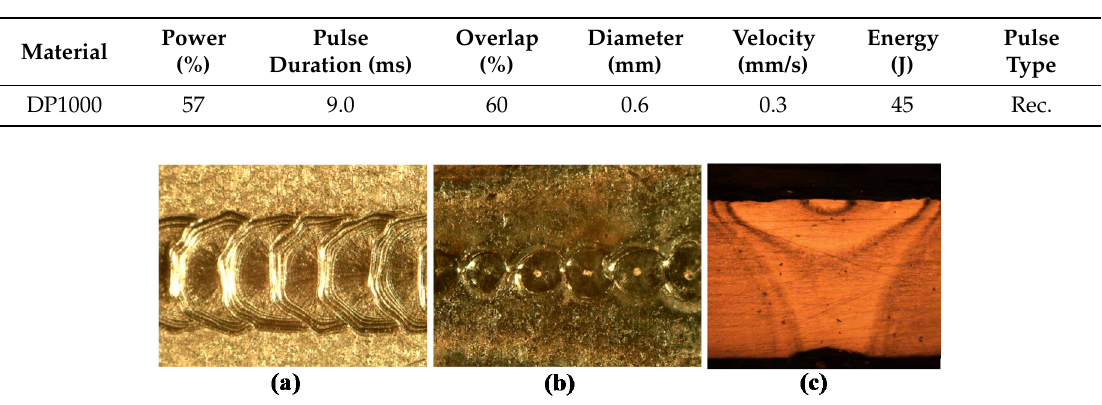
Figure 16. Weld surfaces of fusion zone using the optimal parameters: ( a ) Top surface (15 × ); ( b ) bottom surface (15 × ); ( c ) perpendicular longitudinal section.